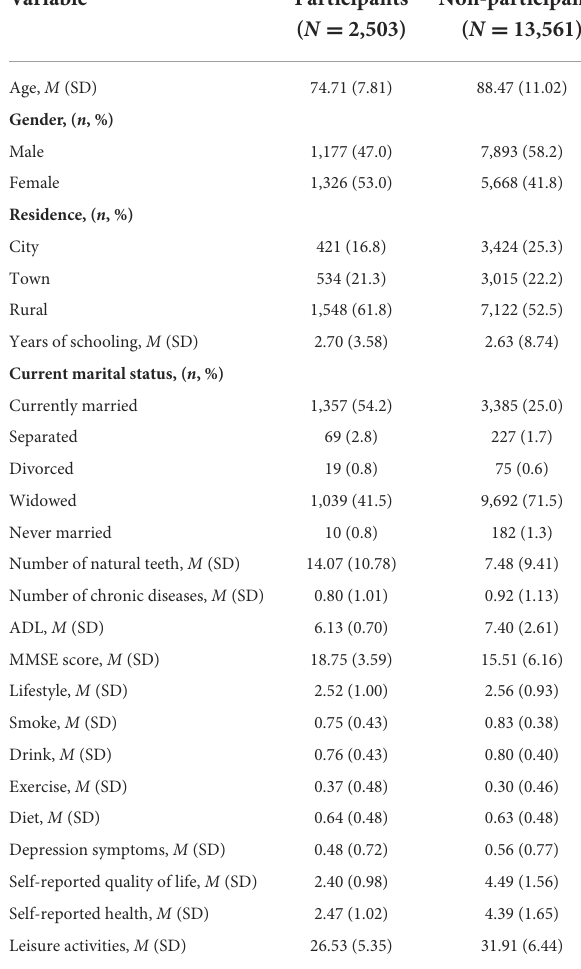
TABLE 1 Baseline characteristics between participants and